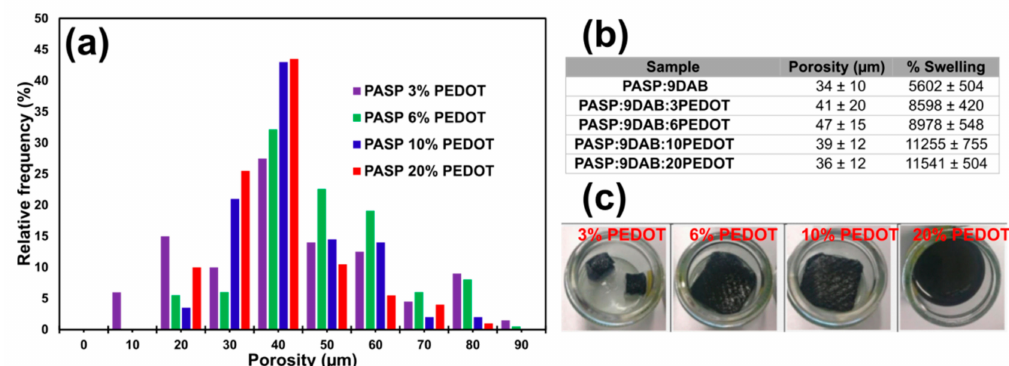
Figure 4. ( a ) Pore size distribution histogram of PASP/PEDOT hydrogels synthesized using different PEDOT percentages. ( b ) Overview of the porosity and swelling values (standard deviation is also shown). ( c ) Structural stability of cross-linked and swelled PASP/PEDOT